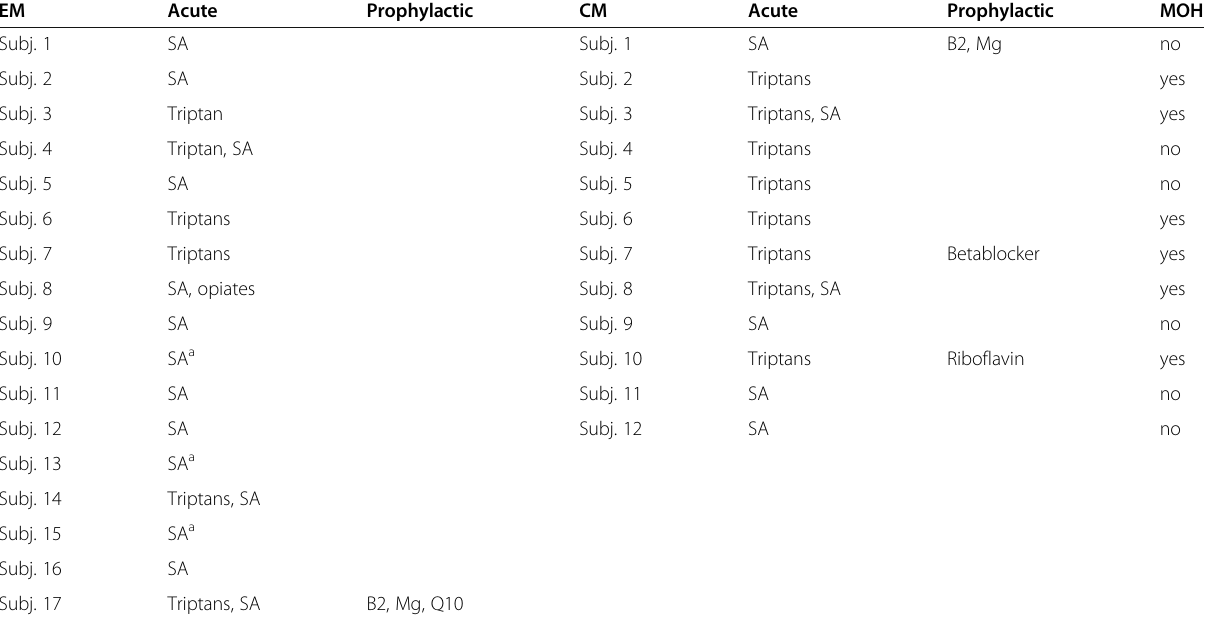
Table 2 List of the preventive (prophylaxis and acute medication) therapy for each